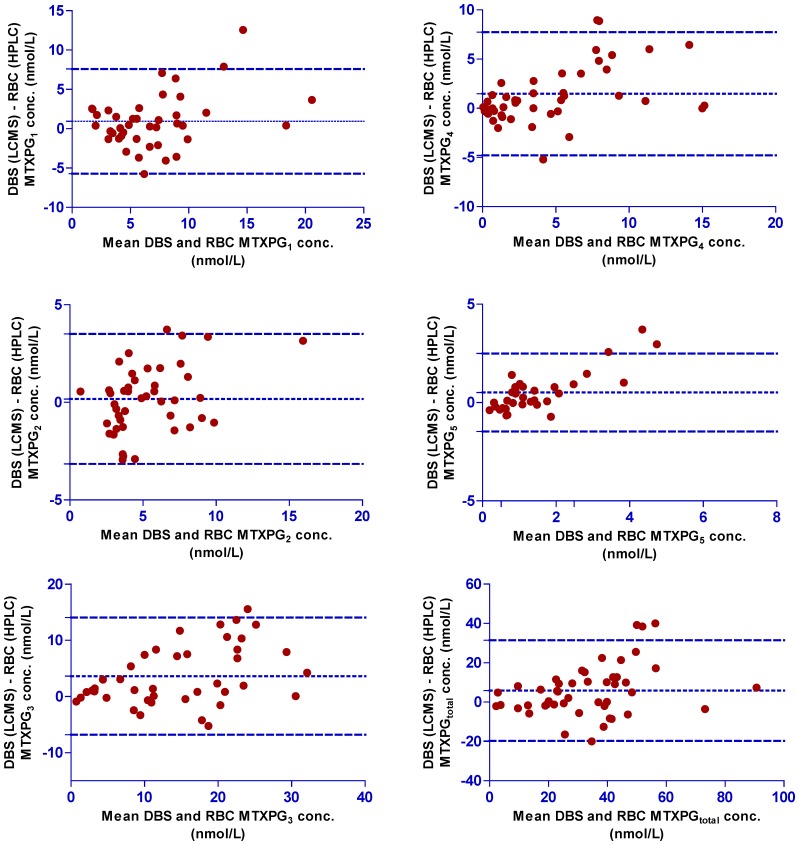
Bland-Altman plots comparing MTXPG1–5 and MTXPGtotal concentrations in DBS versus RBCs in all patient samples investigated (n = 94).